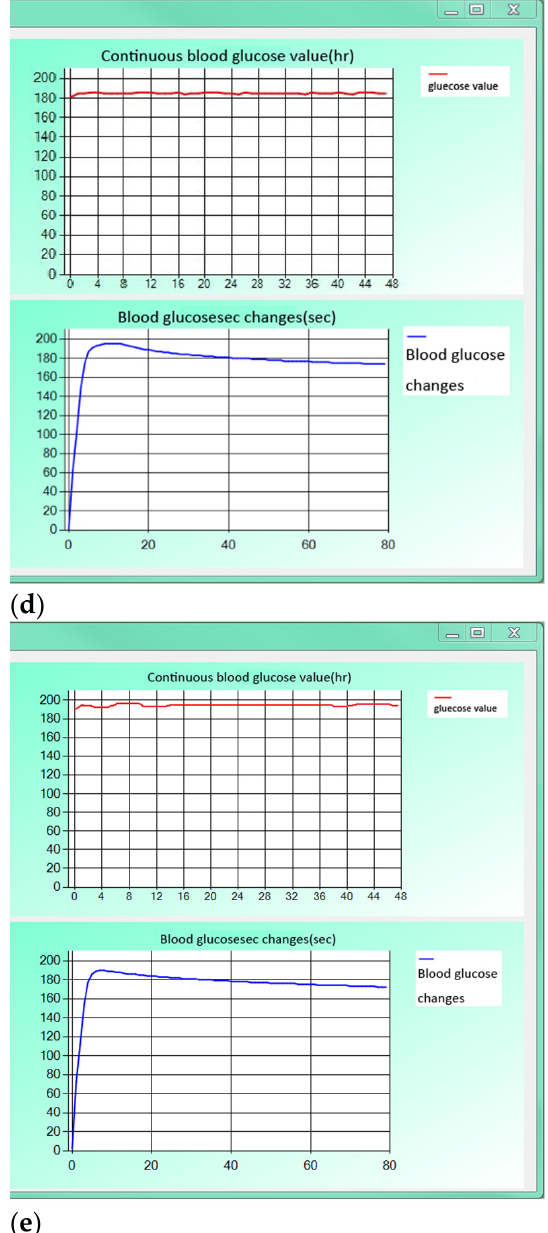
Figure 13. Continuous measurement of concentrations of ( a ) 50 mg/dL; ( b ) 100 mg/dL; ( c ) 200 mg/dL; ( d ) 300 mg/dL; ( e ) 400 mg/dL of glucose